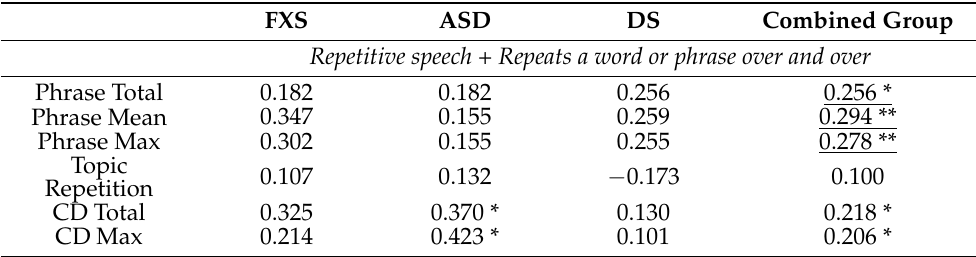
Table 7. Correlations between repetitive language measures and ABC summed score while controlling for number of C-units.